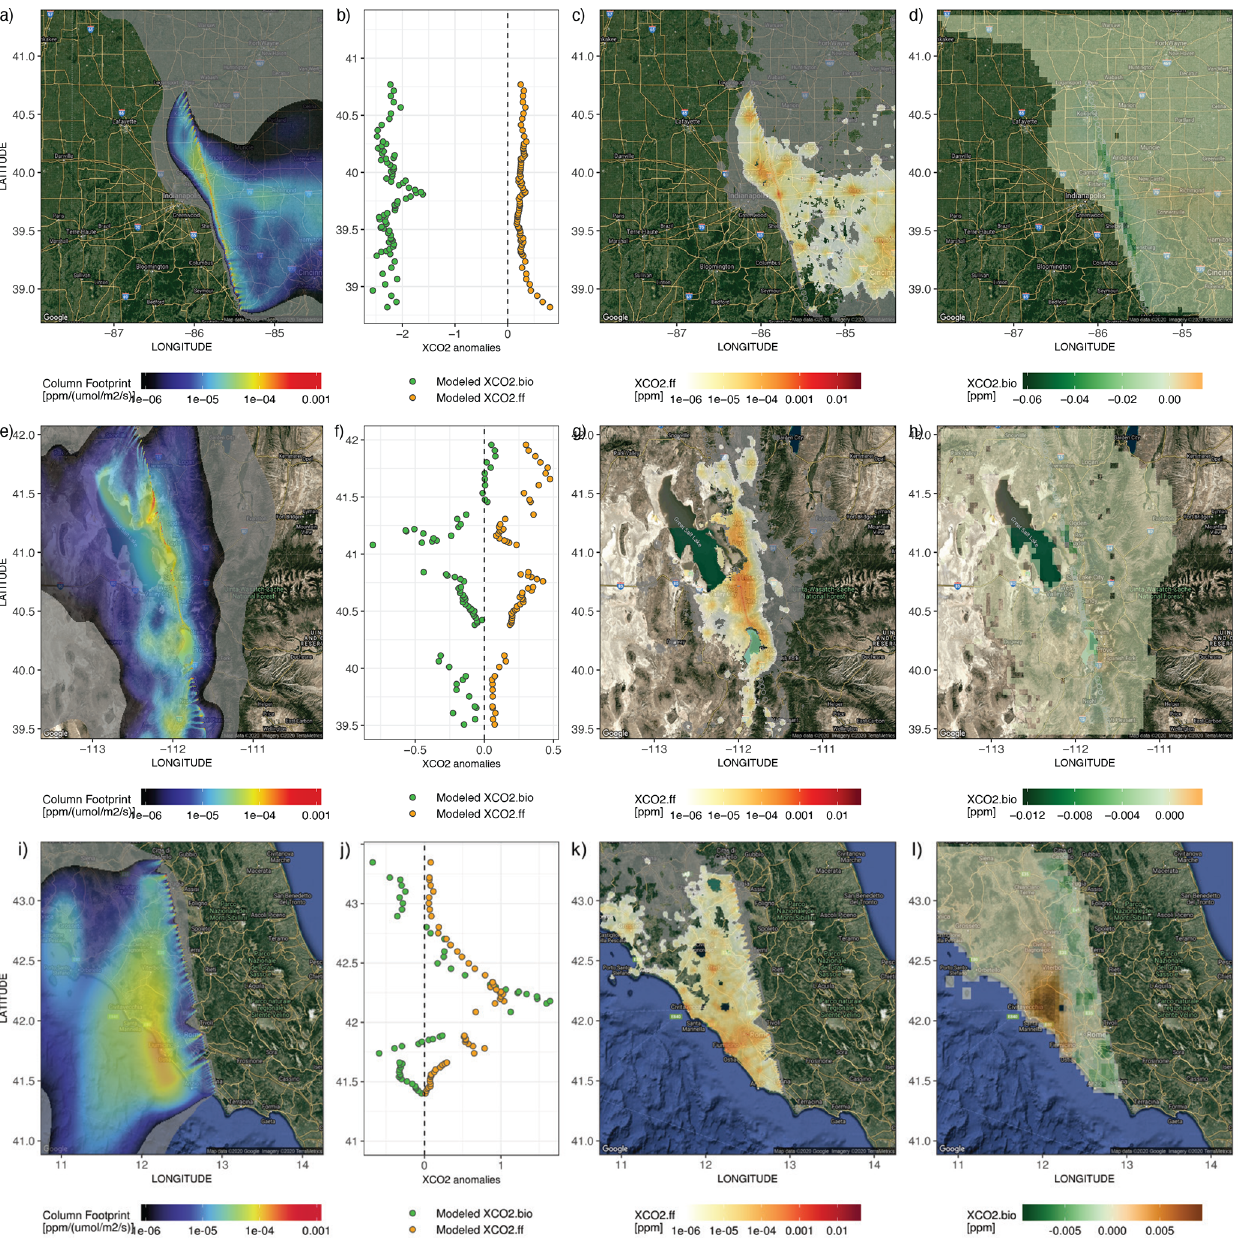
Figure 13. Similar to Fig. 12a–d but for three different OCO-2 tracks, including 18:00UTC on 13 July 2018 to the east of Indianapolis (2018071318; first row, a–d ), 20:00UTC on 25 June 2018 right over Salt Lake City (2018062520; second row, e–h ), and 12:00UTC on 15 June 2017 near Rome, Italy (2017061512; third row, i–l ). The meteorological fields that drove those simulations are 3km HRRR for US cities and 0.5 ◦ GDAS fields for Rome. Note that the underlying hybrid satellite images in the first, third, and fourth columns were generated using the ggmap R library with Google Maps (Map data © 2020 Imagery © 2020